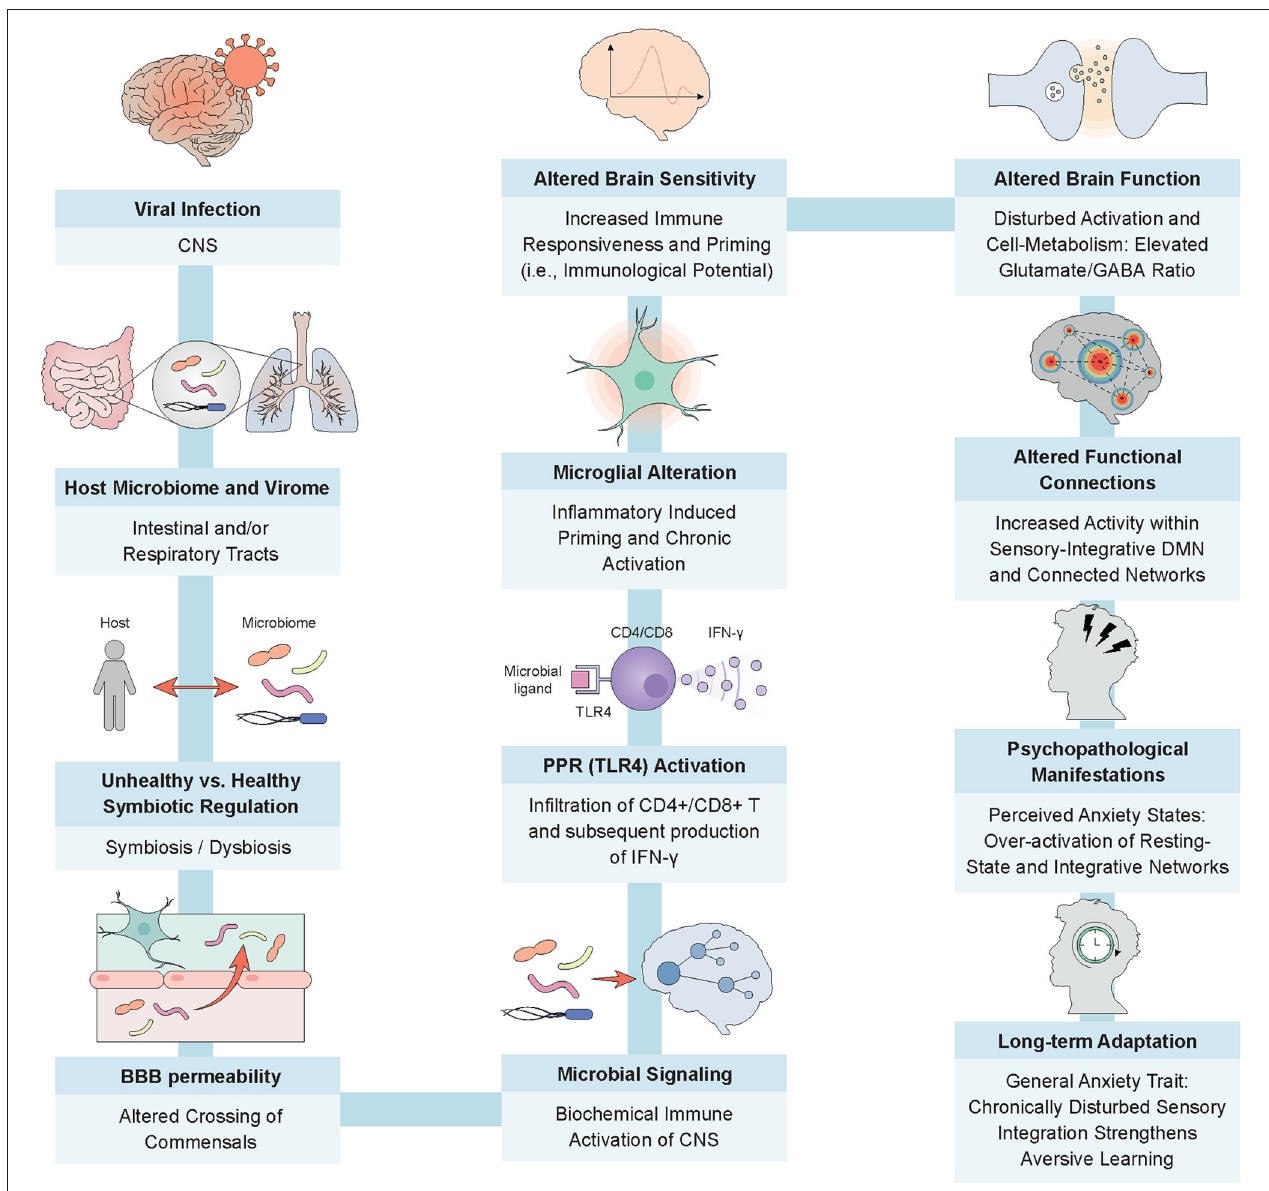
FIGURE 1 | From viral infection to trait anxiety; the intricate processes of a microbially-guided immune response. The model depicts a potential route for the emergence of trait anxiety post SARS-CoV-2 infection. Depending on the host’s microbial homeostasis, increased permeability of barriers, for example, gut and blood brain, fosters the migration of commensals and associated immune cells, such as macrophages, into the vasculature (8, 9). Microbial dysbiosis can also promote the crossing of enhanced levels of endotoxic products and proinflammatory stimulating microbes through a disrupted mucosal epithelium, activating TLR4 receptors on dendritic cells. This phenomenon has the potential to facilitate the exchange of neurochemical signals and commensal products through the blood brain barrier, thereby stimulating the infiltration of CD4 + and CD8 + T cells and the subsequent production of IFN-I within the CNS by way of microglial activation (10–12). Enhanced immunocyte entrance into the privileged brain compartment may also generate inflammatory responses in the resident sentinel immune cells, namely microglia. Abnormal microglial priming and successive chronic activation may cause increased glutamate release in virally-altered, high-density neuronal structures, modulating the functional connectivity of brain networks responsible for information integration processes (13–15). Chronic activation of immunological and neurological responses, for example, a disturbed coordination between the excitatory neurotransmitter glutamate and inhibitory neurotransmitter gamma-aminobutyric acid (GABA) in the form of an elevated glutamate/GABA ratio, may lead to insufficient deactivation of major modulatory networks, such as the default mode network, and to over-attentiveness to perceptually integrated stimuli (i.e., rumination) (16). This has the potential to lead to negative reinforcement learning and perceived states of anxiety (17). The consistent subliminal inflammation caused by the persistent virus upholds the microbial dysbiosis, reinforcing the negative cycle of suboptimal organismic functioning and maintaining the individual in this anxious state, which, as we now surmise, later manifests as trait anxiety (17–20).